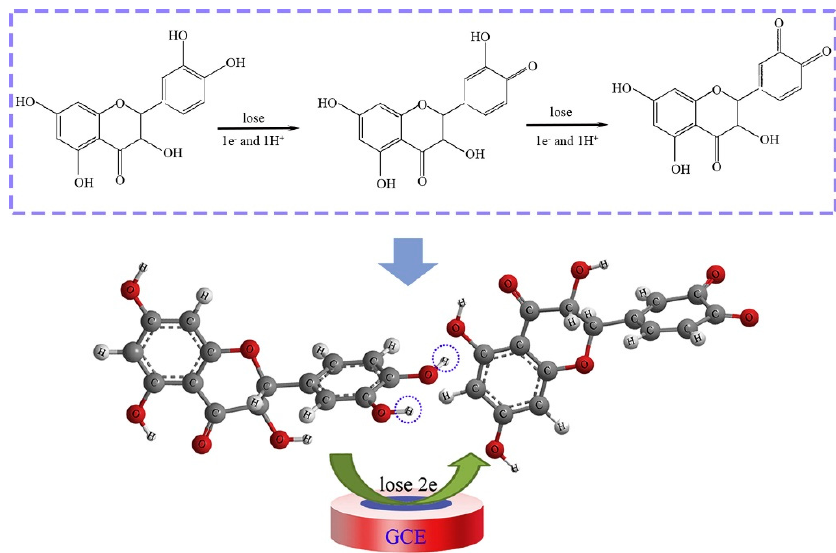
Figure 8. The redox reaction mechanism of taxifolin at MoS 2 /ANC/GCE. Reprinted from ref. [61] with permission of Elsevier.